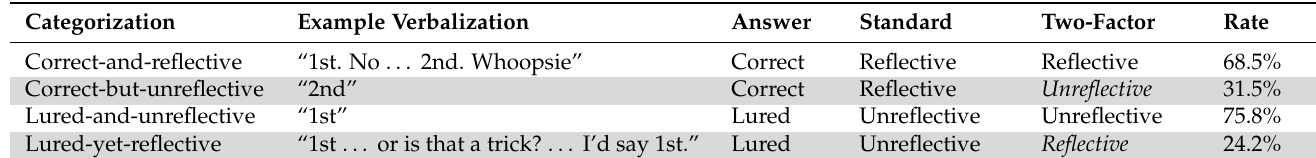
Table 2. Standard and two-factor categorizations of reflection test responses based on think-aloud protocol analysis of responses to the verbal reflection test in Study 2. Example verbalization based on the following reflection test question: “If you were running a race, and you passed the person in 2nd place, what place would you be in